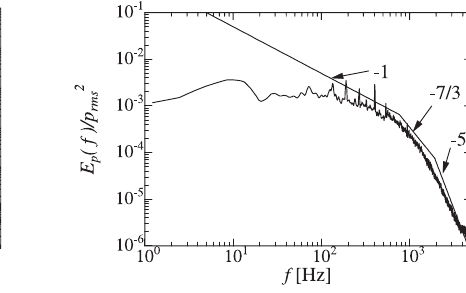
Fig. 5 Power spectrum of wall static pressure